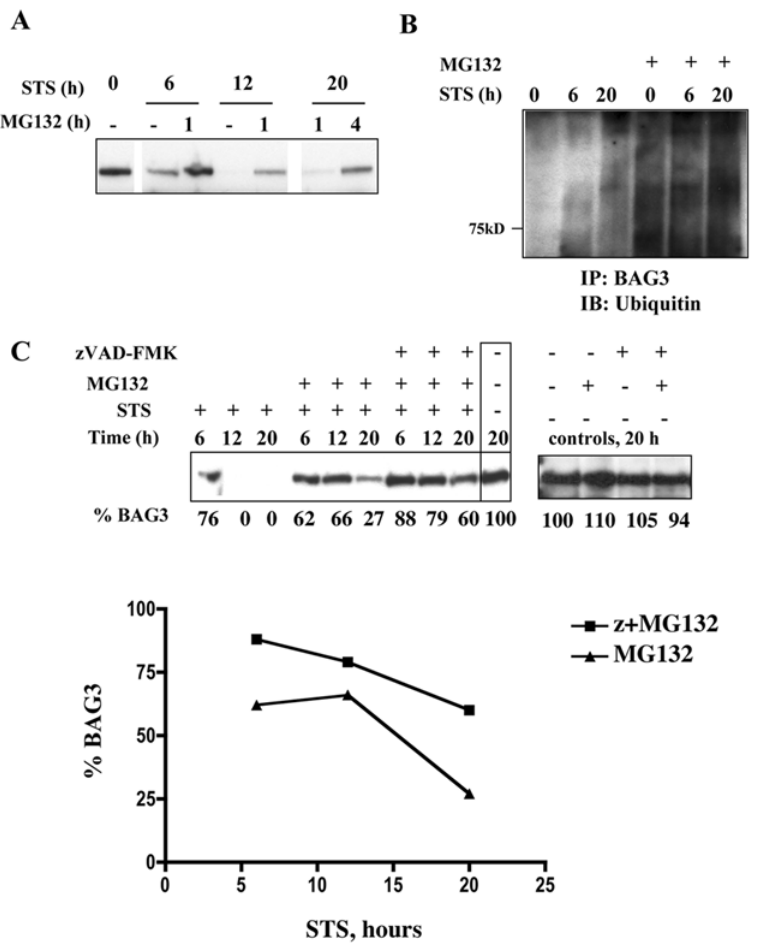
Figure 4. Sequential inhibition of caspases and proteasome provides collaborative protection of BAG3. A. Proteasome inhibition provides dose-dependent partial protection of BAG3. FL-BAG3 cells were pretreated with 20 m M MG-132 for 1 or 4 hrs prior to exposure to 2 m M STS. Inhibition of proteasomal degradation by pretreatment with MG-132 prior to STS exposure reduced BAG3 degradation. B. BAG3 is ubiquitinated in response to STS treatment. FL-BAG3 cells were treated with 2 m M STS alone or following 4 hr preincubation with 20 m M MG-132. Lysates were immunoprecipitated with anti-BAG3 and the immunoblots were probed for ubiquitin. BAG3 was ubiquitinated and degraded in the absence of proteasome inhibition. C. STS-induced loss of BAG3 is minimized by the combination of caspase and proteasomal inhibition. FL-BAG3 cells were preincubated with 0.05% DMSO vehicle or 20 m M MG-132 for 4 hours with or without 1 additional hour of zVAD preincubation (85 m M). Treatments were followed by a total STS exposure of up to 20 hrs. A progressive retention of BAG3 was seen with inclusion of each inhibitor. Relative levels of BAG3, determined using ImageJ TM , are indicated below the respective blots and plotted as percent remaining BAG3 with increasing STS time.